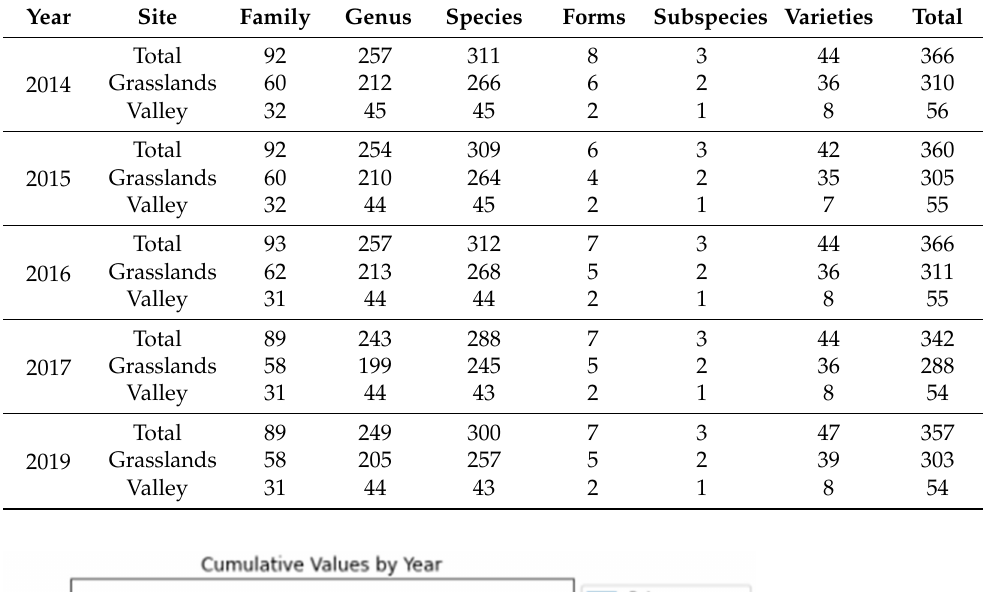
Table 3. Summary of plant taxa in the study sites by year.